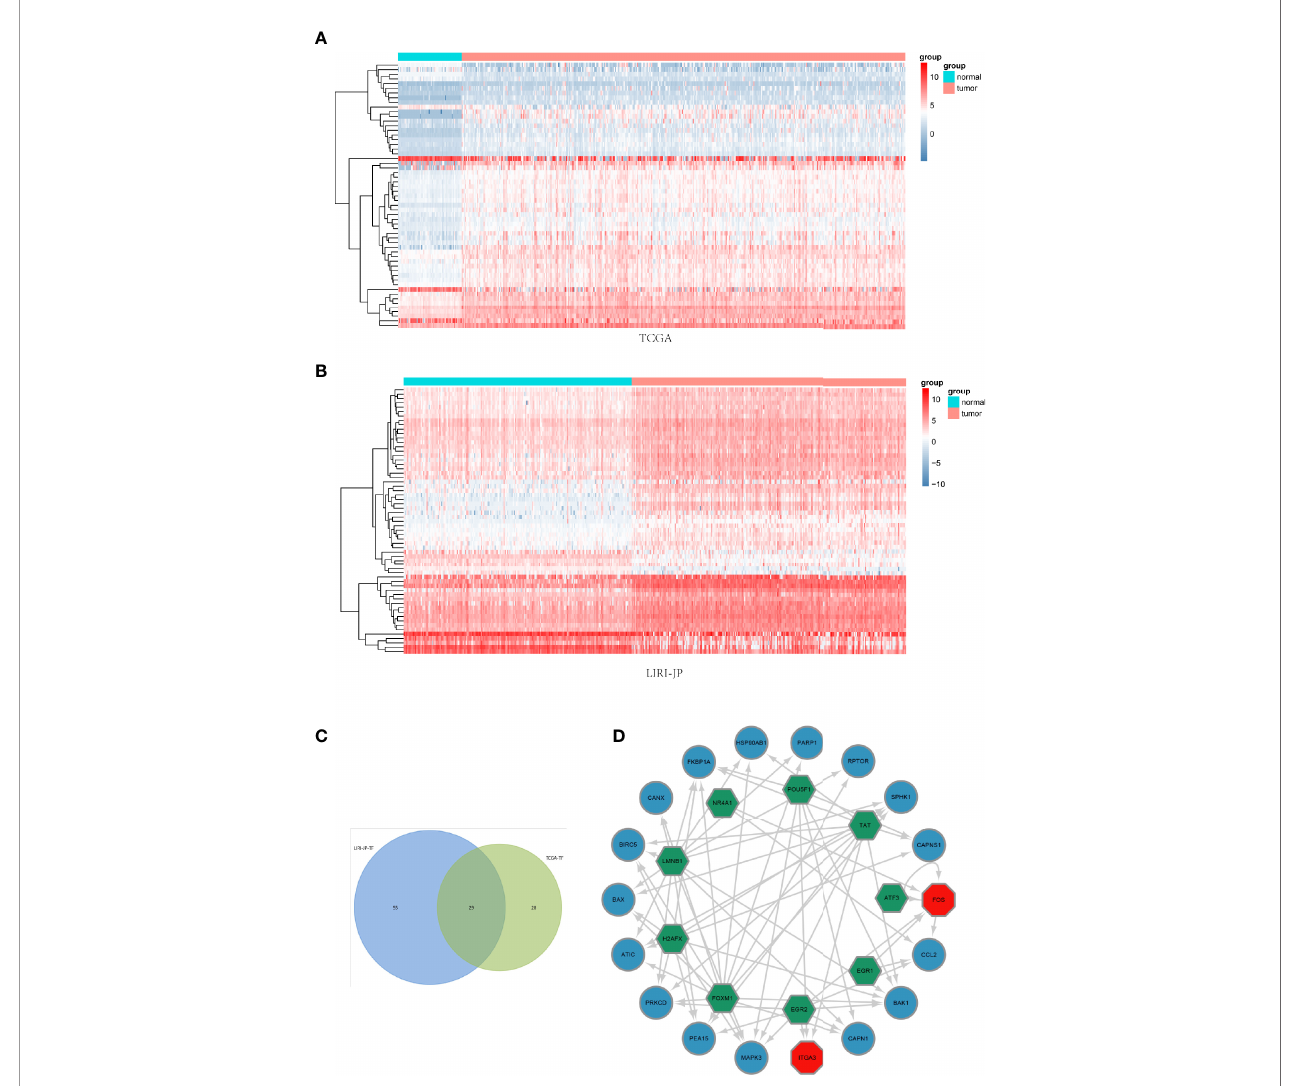
FIGURE 3 | Coexpression network of the differentially expressed transcription factor (TF) genes and differentially expressed autophagy-related genes (ARGs). (A, B) Clustering analysis of differentially expressed TFs for TCGA and ICGC databases. (C) Venn diagrams of the overlapping differentially expressed TFs between TCGA and ICGC datasets. (D) The coexpression networks. Green hexagons represent TF genes, blue circles represent low-risk ARGs, and red octagons represent high-risk